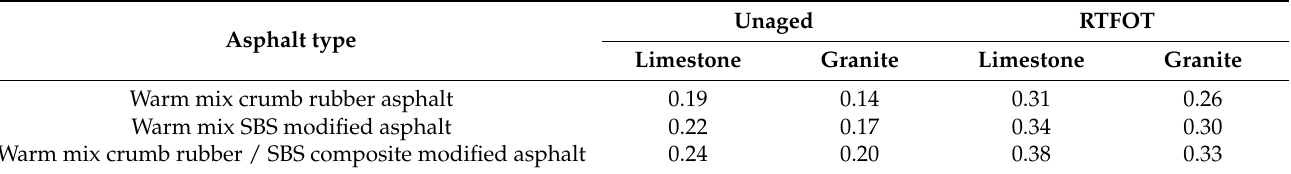
Table 11. The pull-off force of asphalt and aggregate before and after short-term aging (MPa). Unaged RTFOT Asphalt type Limestone Granite Limestone Granite Warm mix crumb rubber asphalt 0.19 0.14 0.26 Warm mix SBS modified asphalt